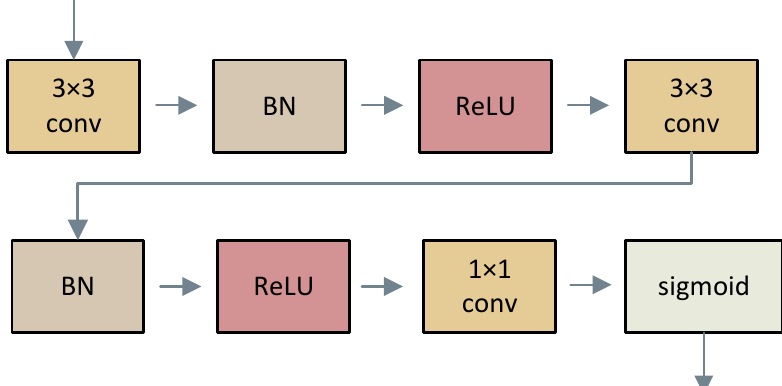
Figure 6. Schematic diagram of the structure of the detection head, where ”3 × 3 conv” represents a convolutional layer with a convolutional kernel size of 3 × 3, ”BN” represents the batch normalization layer, ”ReLU” represents the ReLU activation function, and “sigmoid” is the sigmoid activation